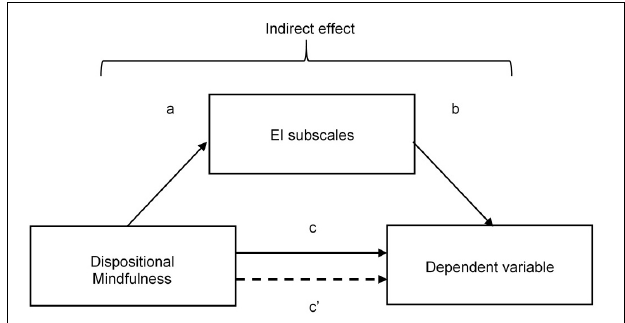
FIGURE 1 | Mediation model with the predictor variable of dispositional mindfulness and the dependent variable of either anxiety or depression, mediated by El subscales. c, total effect in simple model where the mediator is not present; c’, direct effect in mediation model where the mediator is present.